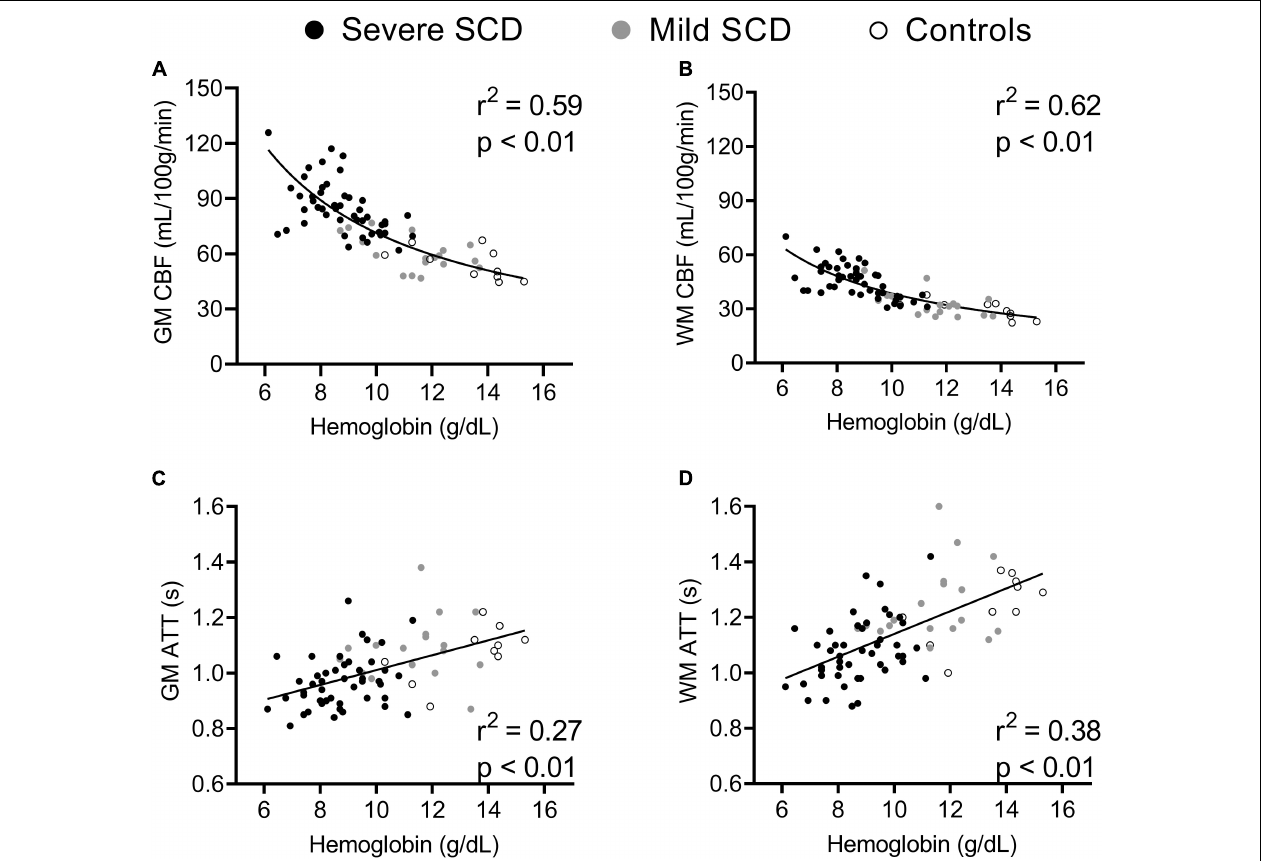
FIGURE 3 | Scatterplots displaying correlations between hemoglobin and GM and WM CBF (A,B) and GM and WM ATT (C,D) at